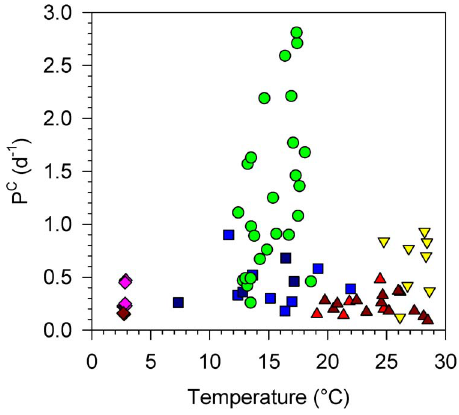
Figure 2. Temperature and phytoplankton growth. Carbon- specific production rate (P C ) plotted against temperature for all stations. Symbols as in Fig. 2. doi:10.1371/journal.pone.0099312.g002 PLOS ONE |